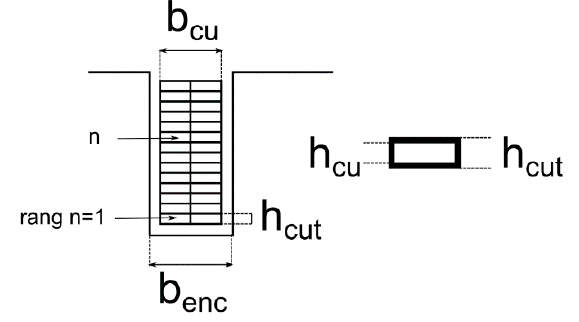
Figure 9. Description of the